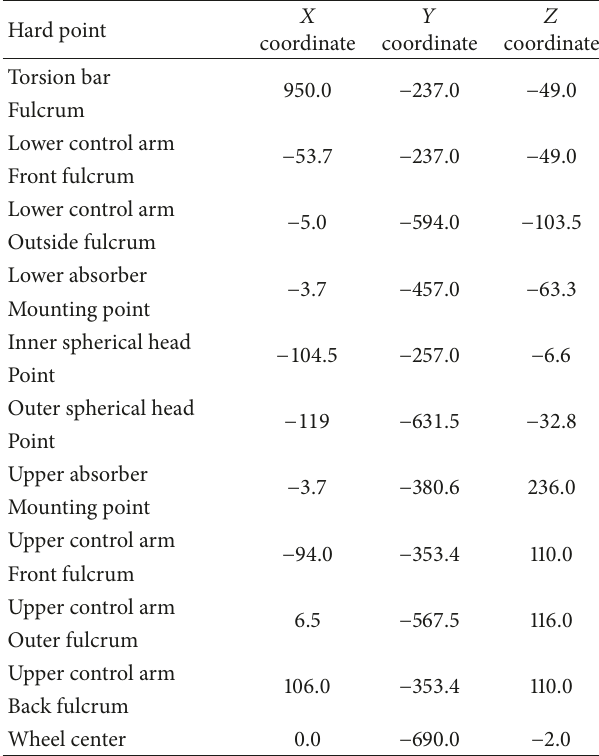
Table 1: The hard point coordinates of front